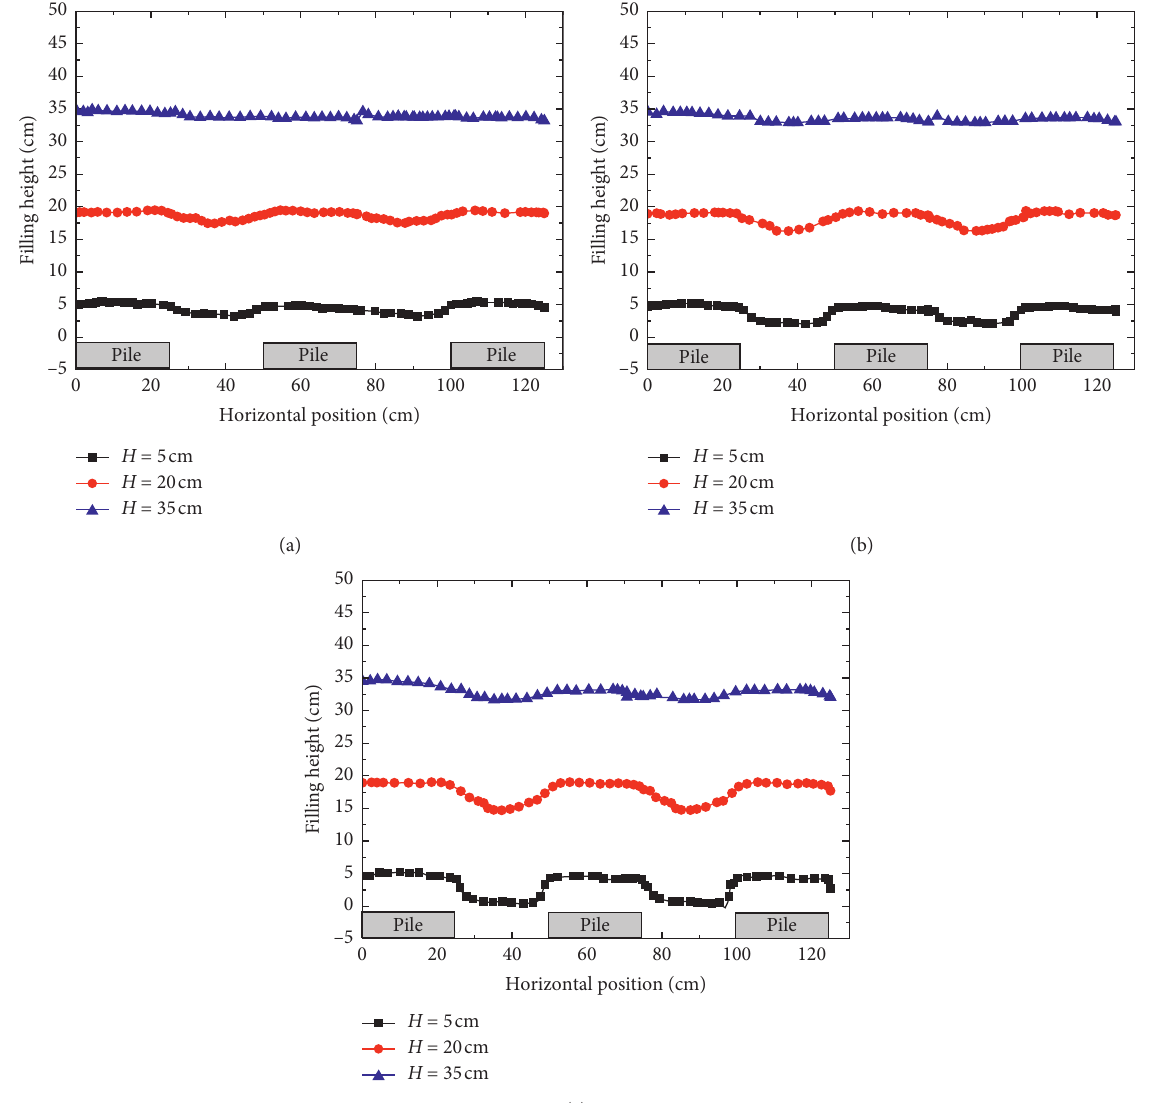
Figure 4: Settlement curves at different filling heights. (a) Consolidation settlement of 10mm. (b) Consolidation settlement of 30mm. (c) Consolidation settlement of